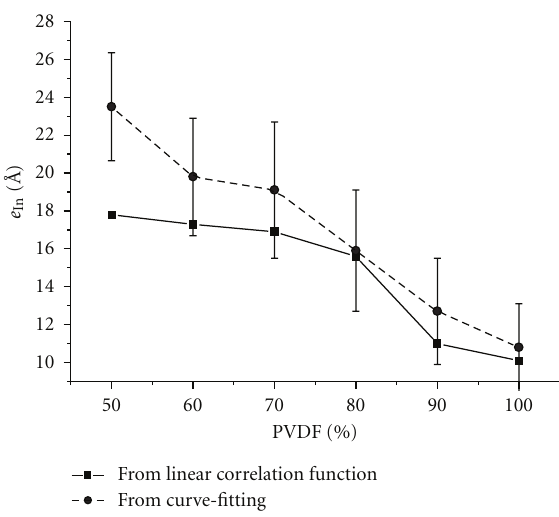
Figure 4: Average interface thickness deduced from linear correla- tion function γ ( r ) and